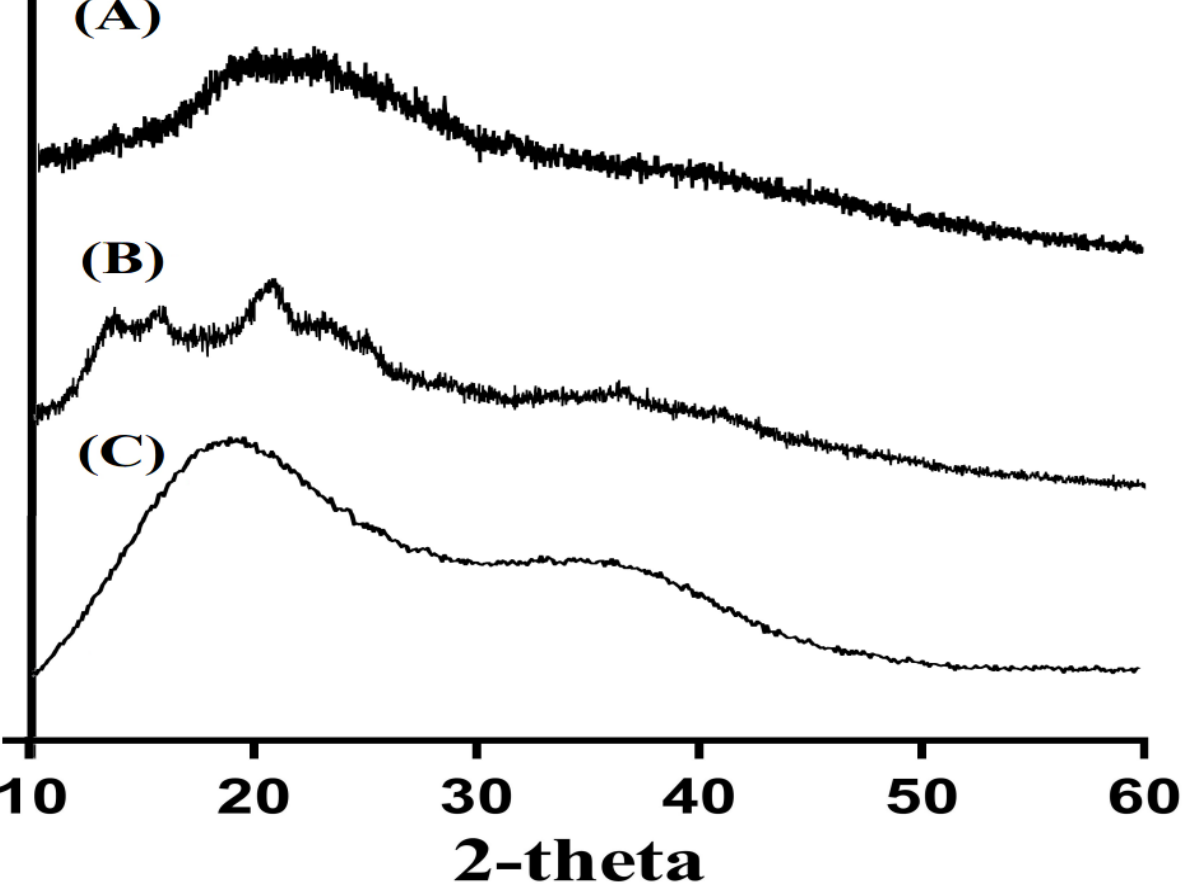
Figure 5. PXRD of ( A ) CS, ( B ) Al, and ( C ) CS/Al- g -pAa hydrogel. Figure 5. PXRD of (A) CS, (B) Al, and (C) CS/Al-g-pAa